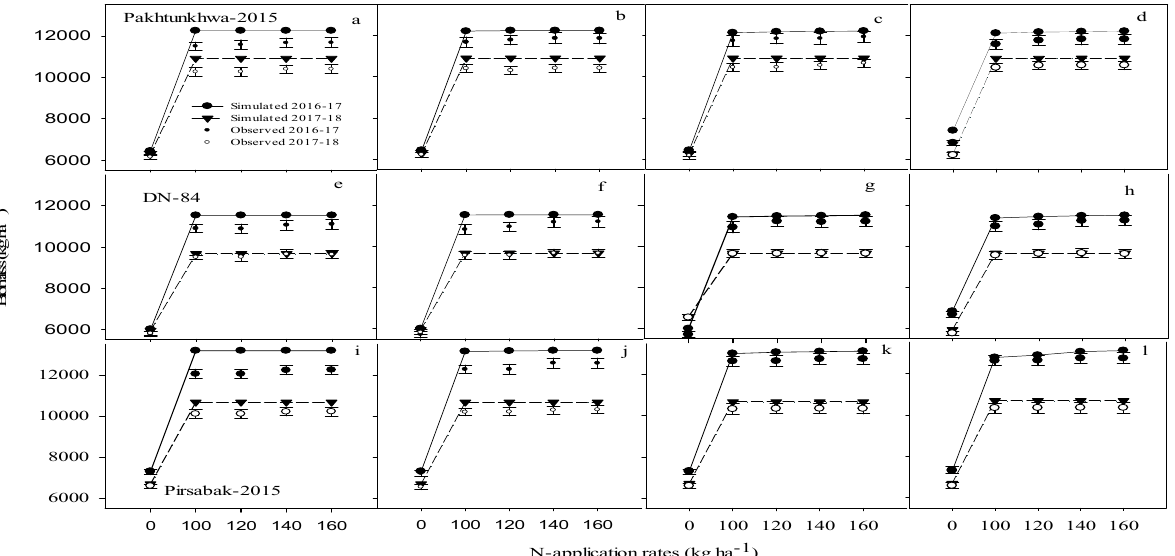
Figure 5. Using CSM-CERES-Wheat to predict biomass (kg ha − 1 ) as a function of N application at different stages: full N application (N 100% ) at sowing ( a , e , i graphs), half of recommended N application (N 50% ) at sowing + N 50% at tillering ( b , f , j graphs), quarter of recommended N application (N 25% ) at sowing + N 50% at tillering + N 25% at booting ( c , g , k graphs), and N 25% at sowing + N 25% at tillering + N 50% at booting stage ( d , h , l graphs) for different cultivars.